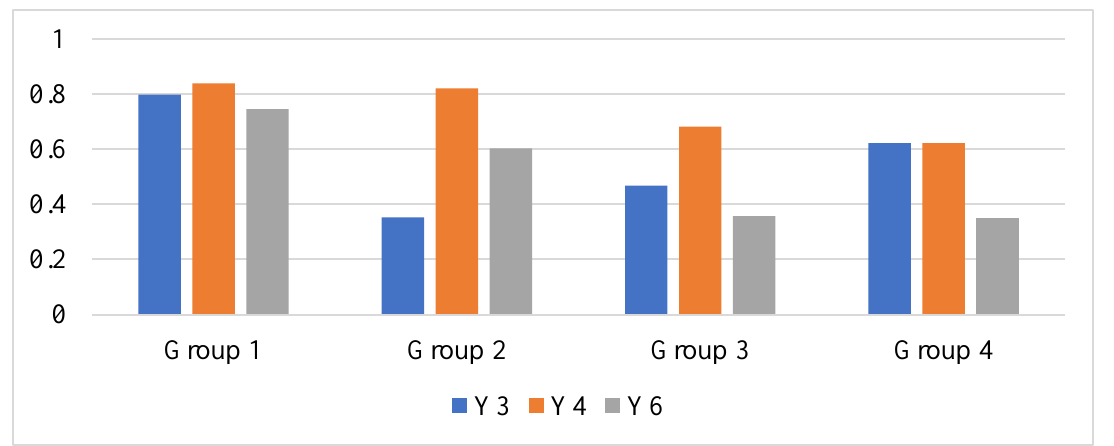
Figure 3. The highest values of correlation coefficients between the level of digitalization and key indicators of banks (absolute value of a number).